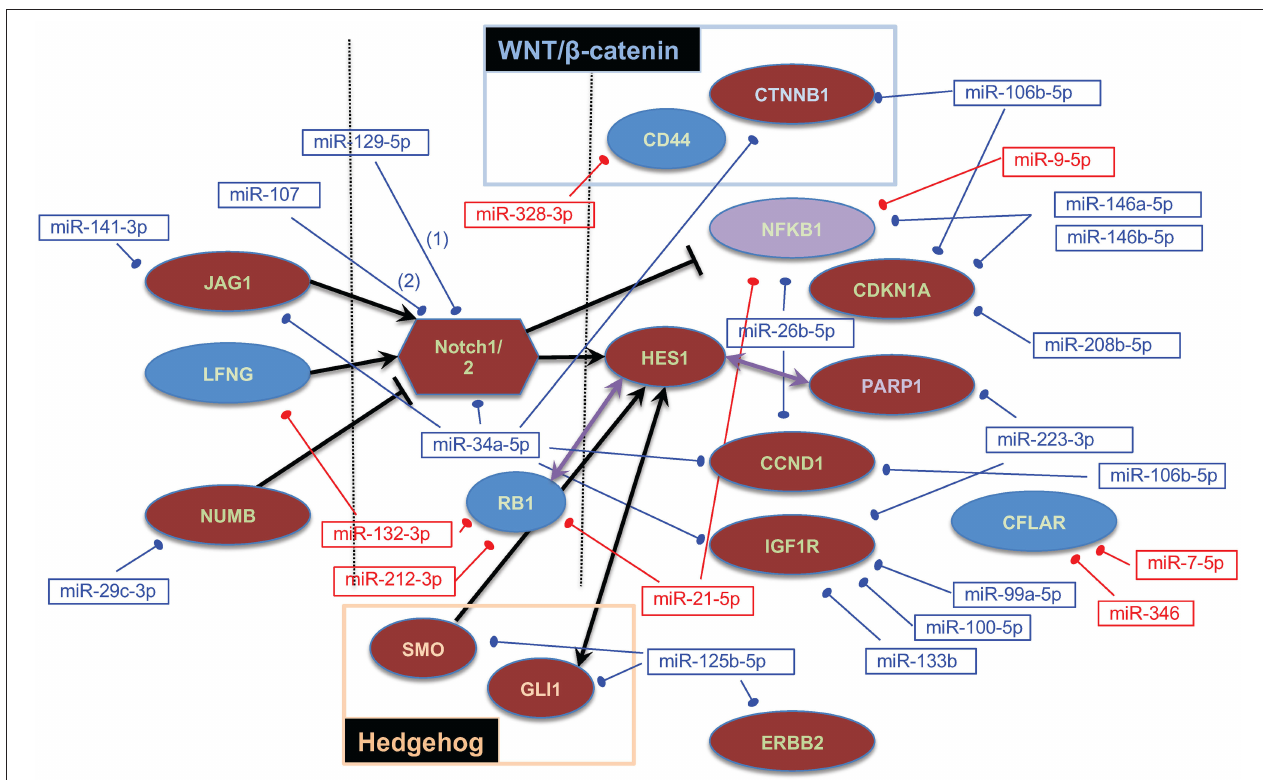
FIGURE 3 | Notch/HES1-associated miRNA–mRNA interactions. Dysregulated genes are shown as ovals or polygons, dysregulated miRNAs are shown in text boxes. In both cases, red indicates expression that is higher in tumors than in normal bone, blue indicates expression that is lower in tumors, and purple indicates that one probe in the Affymetrix array showed NFKB1 as upregulated and another as downregulated. Genes on the left are ligands or inhibitors of Notch; genes on the right are downstream targets of the Notch signaling pathway and/or specifically interact with HES1.